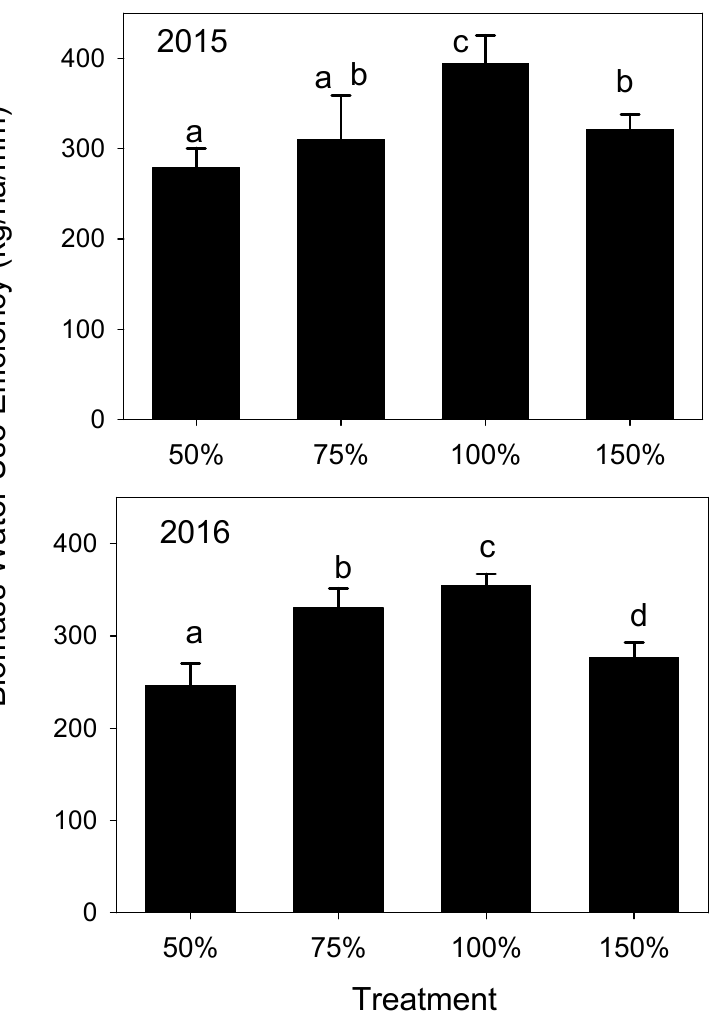
Figure 5. Water use efficiency of irrigation treatments for both trials, based on above ground biomass yields. Treatments are 50–150% of crop water requirement. Treatment means with different letters (a–d) are statistically different at the p < 0.05 confidence level. Error bars represent standard deviations of treatment means.